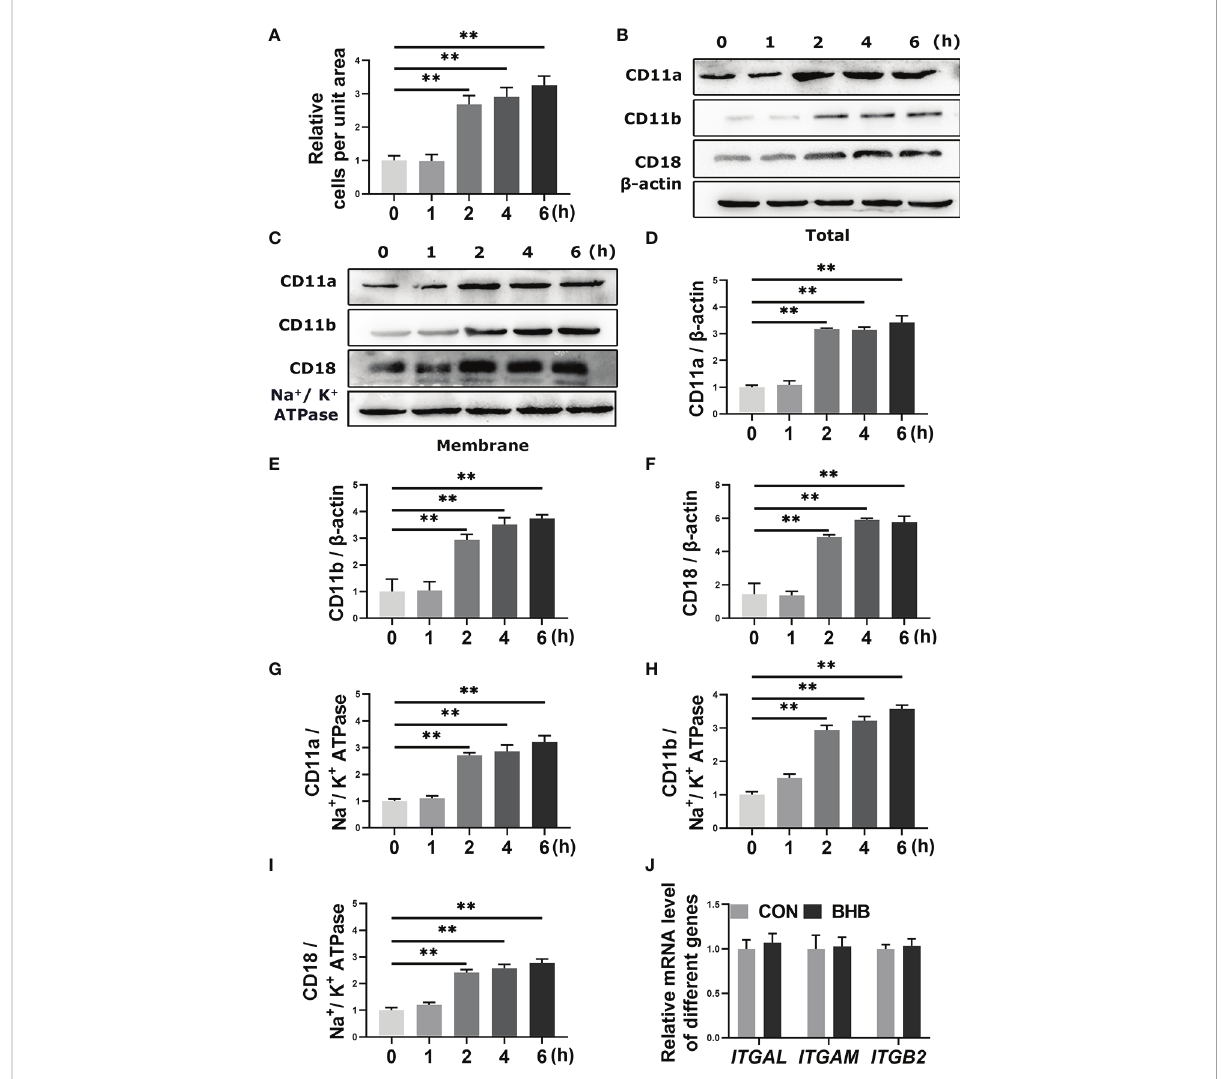
FIGURE 1 Effect of BHB with different stimulated times on the adhesion of bovine neutrophils. Neutrophils were treated with 1.6 m M BHB for 0, 1, 2, 4, and 6 h, respectively. (A) Quantitation of the number of adherent neutrophils. (B-I) Protein abundance of membrane and total CD11a, CD11b, and CD18. Representative blots in both groups were shown in B-C. The quanti fi cation was shown in D-I. (J) Neutrophils were treated with 1.6 m M BHB for 2h. mRNA abundance of ITGAL , ITGAM , and ITGB2. For WB experiments, b -actin was used to normalize the total protein abundance, while Na +/ K + ATPase was used to normalize membrane protein abundance; for qRT-PCR experiments, b -Actin and YWHAZ were used to normalize mRNA abundance. Data were expressed as the mean ± SEM. Data were analyzed with a one-way ANOVA with subsequent Bonferroni correction or independent-samples t-tests. ** P < 0.01 as statistically highly signi fi cant. BHB, b -hydroxybutyrate; CD11b, integrin alpha-M precursor; CD11a, integrin alpha-L precursor; CD18, integrin beta-2 precursor; ITGAL , integrin subunit alpha L; ITGAM , integrin subunit alpha M; ITGB2 , integrin subunit beta 2; YWHAZ , tyrosine 3-monooxygenase/tryptophan 5-monooxygenase activation protein zeta ; SEM, standard error of the